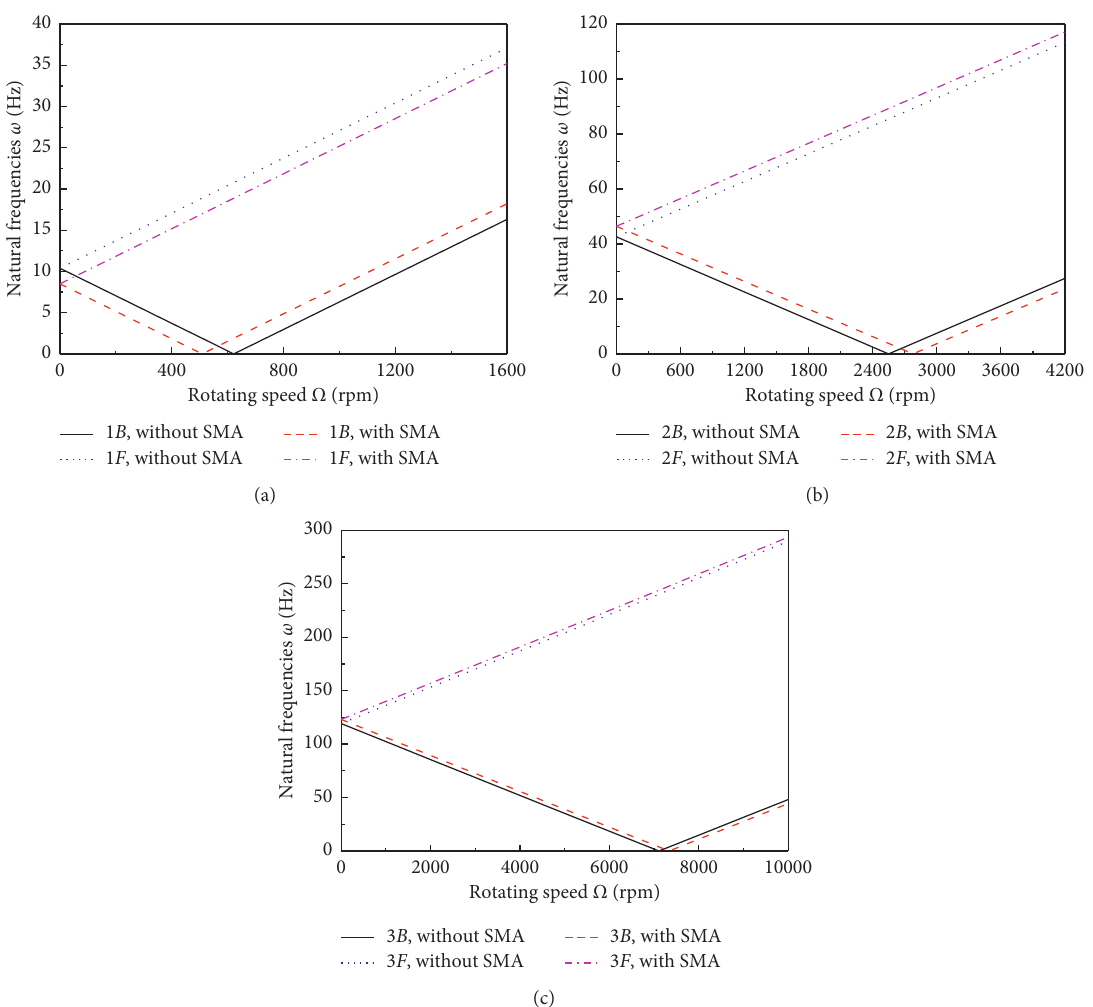
Figure 5: The natural frequencies versus rotating speed of the tapered composite rotating shaft with SMA and without SMA for C-F � 0 . 005): (a) the first mode; (b) the second mode; (c) the third boundary condition ( σ � 0 . 5 , θ � 30 ° ,Vs � 0 . 1 ,T � 50 ° C , ε 0